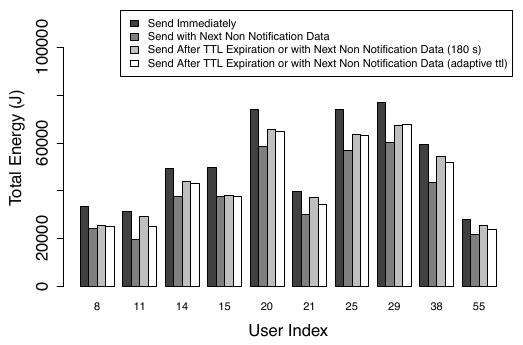
Figure 6: Influence of Varying Slot Duration (in seconds) on the TTL Estimation